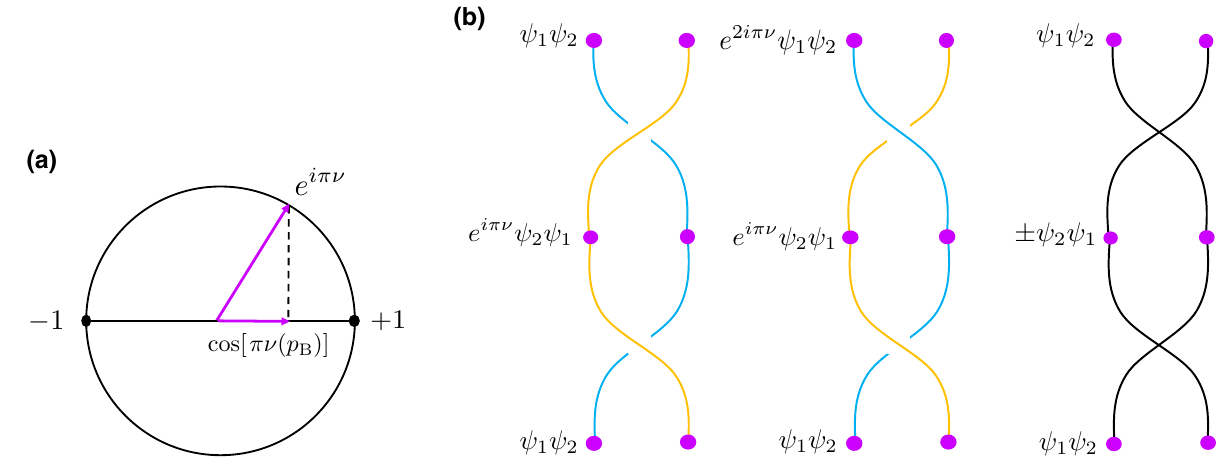
FIG. 2. (a) Comparison between the exchange phases of topological and statistical anyons. For topological anyons the direction of the exchange (clockwise or counterclockwise) determines the sign of the anyonic phase. As such, the space of possible topological anyon exchange phases can be represented by a circle, with bosonic and fermionic symmetry lying on opposite sides. For statistical anyons, the anyonic phase is an average over N B bosonic phase factors and N F fermionic phase factors. As such, the space of possible statistical anyon phases is confined to a line between − 1 and + 1. (b) Comparison between topological and statistical anyons undergoing two interchanges. For topological anyons two exchanges in opposite directions leave the wave function unchanged (left diagram), while two exchanges in the same direction results in the original wave function multiplied by an additional phase of e 2 i πν (middle diagram). For statistical anyons the direction of the exchange is irrelevant, with two exchanges always resulting in an unchanged wave function (right